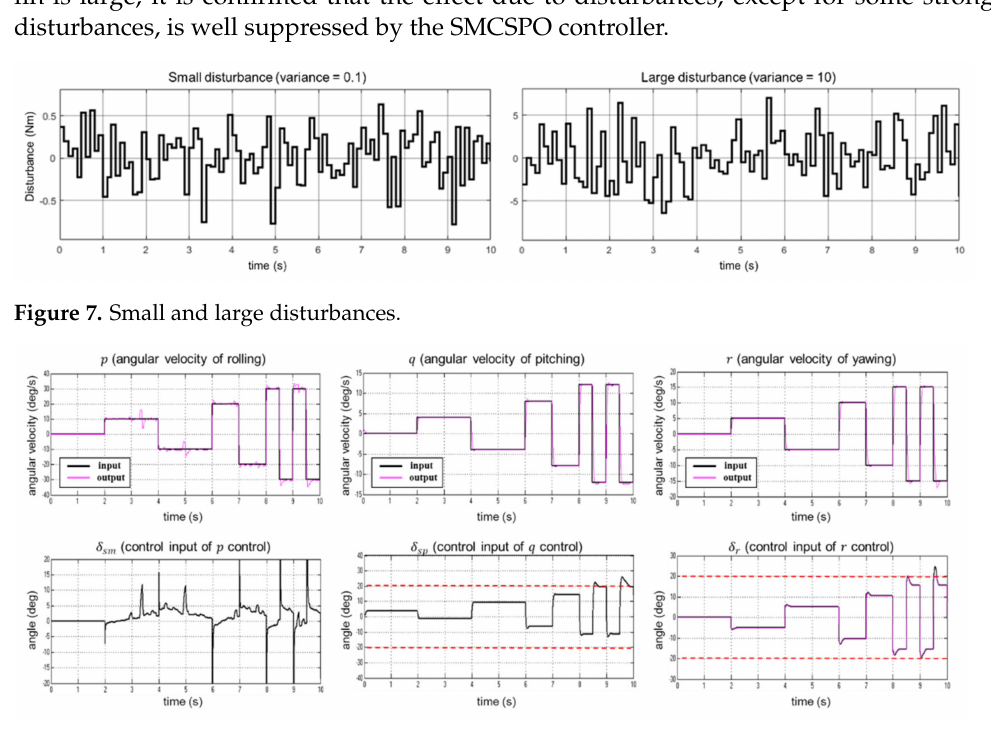
Figure 8. PID control simulation results with small disturbances (variance of magnitude = 0.1).